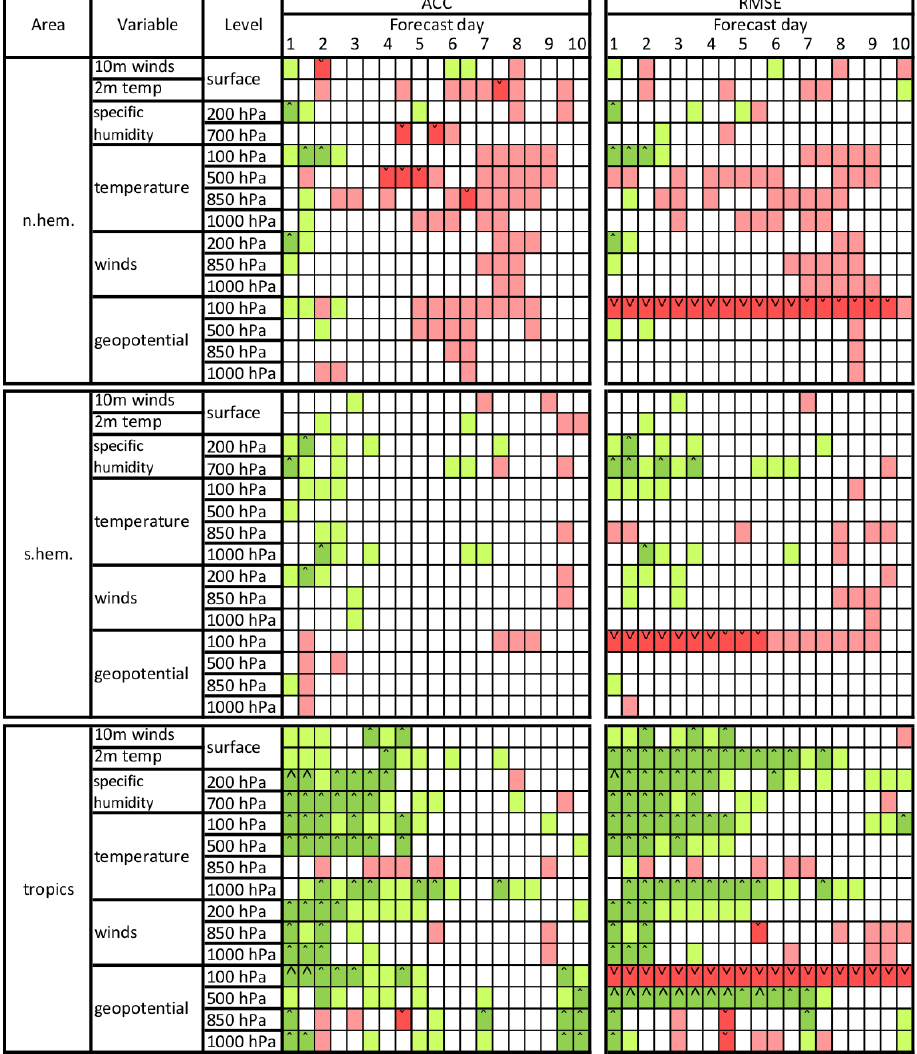
Fig. 4. A forecast validation scorecard for the 45 forecast cases between 12 May 2012 and 8 August 2012 using the following color code: green is good for the optimized model, while red is good for the default model. Small (large) arrow head indicates 95% (99%) level of statistical significance of the sore difference. The 1st column indicates the area, the 2nd the variable, the 3rd pressure level, and the 4th and 5th columns the ACC and RMS score for forecast days